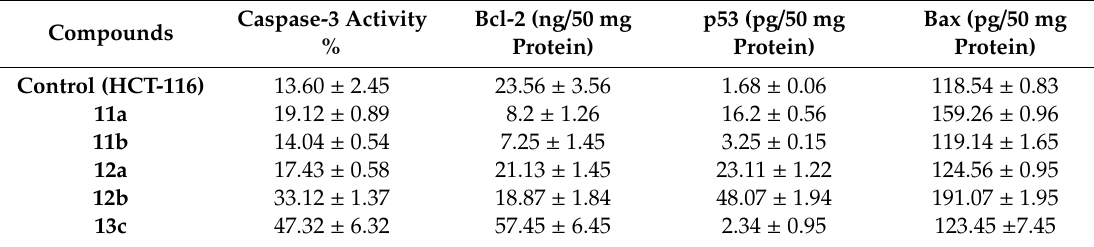
Table 6. E ff ect of compounds 11a, 11b, 12a, 12b and 13c on active caspase-3 levels, and expression levels of Bcl-2 and Bax in HCT-116 cancer cells treated with the compounds at their IC 50 concentrations.